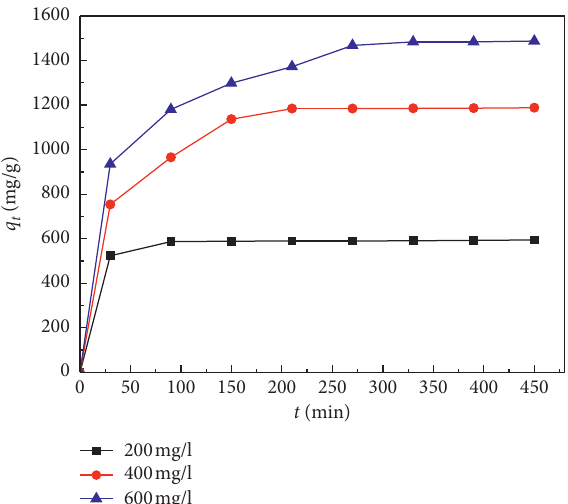
Figure 8: Effects of adsorption time on the adsorption of AR88 by PPAC.